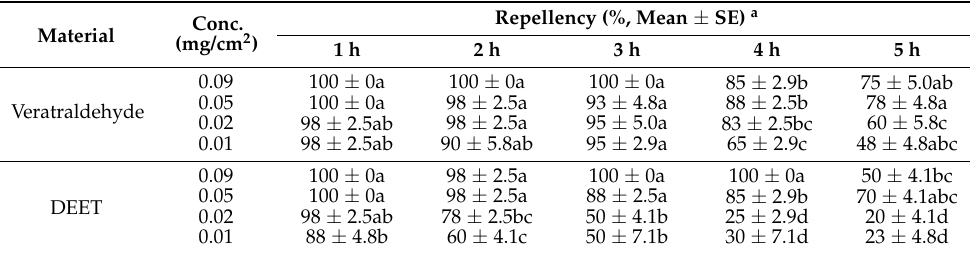
Table 2. The repellent activity of veratraldehyde against Haemaphysalis longicornis nymphs using the filter paper assay.